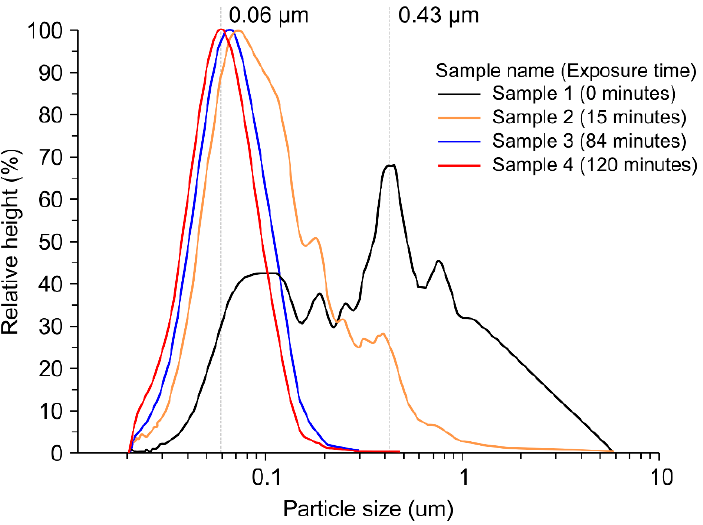
Figure 8. Particle size and size distributions of TiO 2 particles for different ultrasonic exposure times (samples 1 (black, 0 min), 2 (yellow, 15 min), 3 (blue, 84 min), and 4 (red, 120 min)). The ultrasonic wave exposure time increased in the following order: 0 min (black line), 15 min (yellow line), 84 min (blue line), and 120 min (red line). The range of the